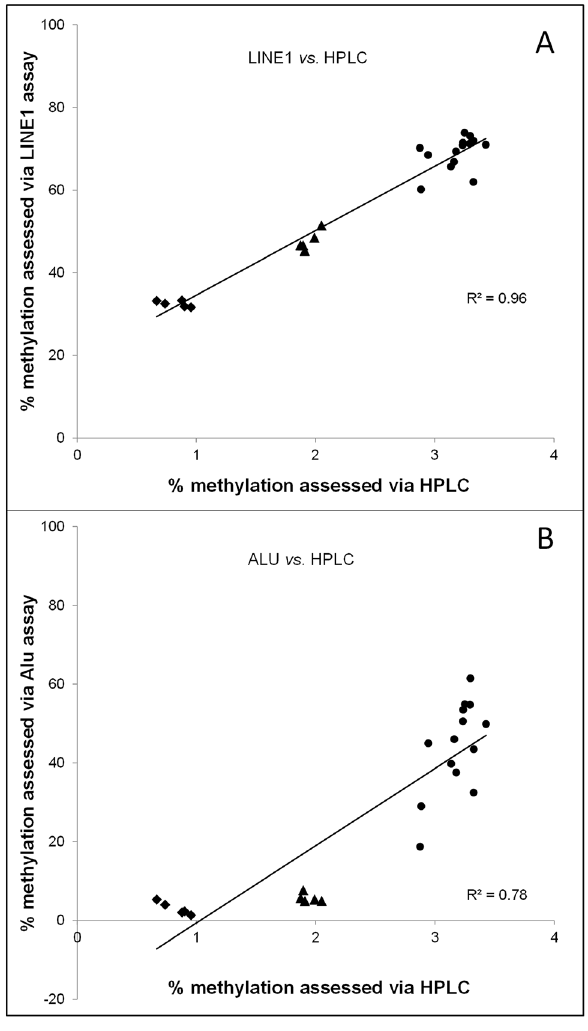
Figure 3. Linear regressions showing the relationships be- N tween assays. U sing both data from the cell lines ( X 5-AzaC treated ), significant linear associations or m untreated) and the colon tissues ( were observed A) between the HPLC method and the LINE1 assay and B) HPLC method versus the Alu assay. Absolute values were used for these